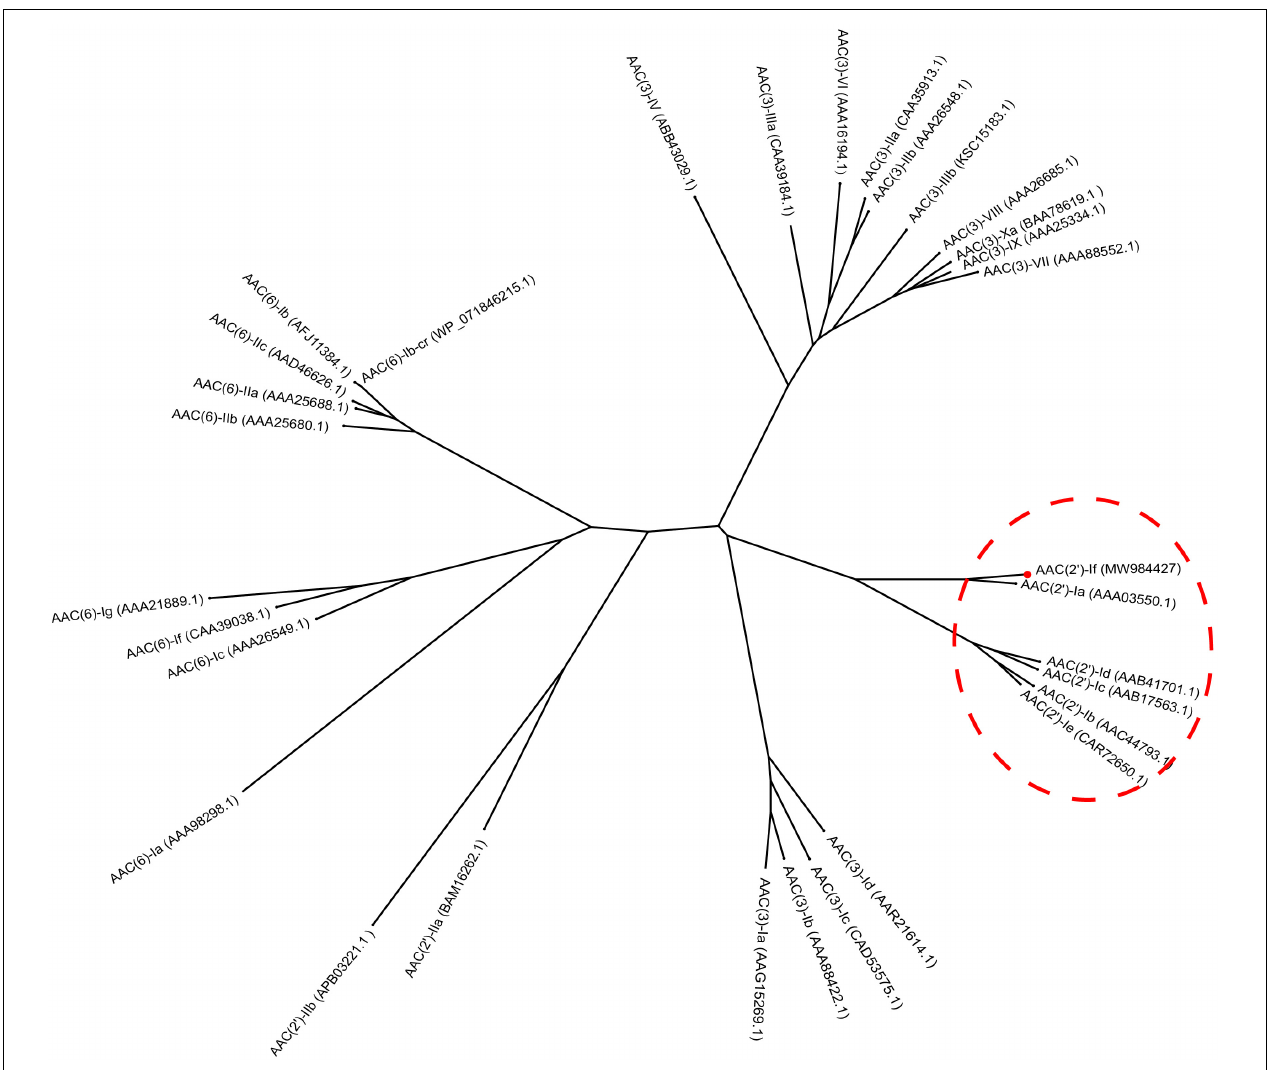
FIGURE 3 | Phylogenetic tree showing the relationship of AAC(2 (cid:48) )-If with other chromosome-borne acetyltransferases. AAC(2 (cid:48) )-If from this study is shown with a red dot.